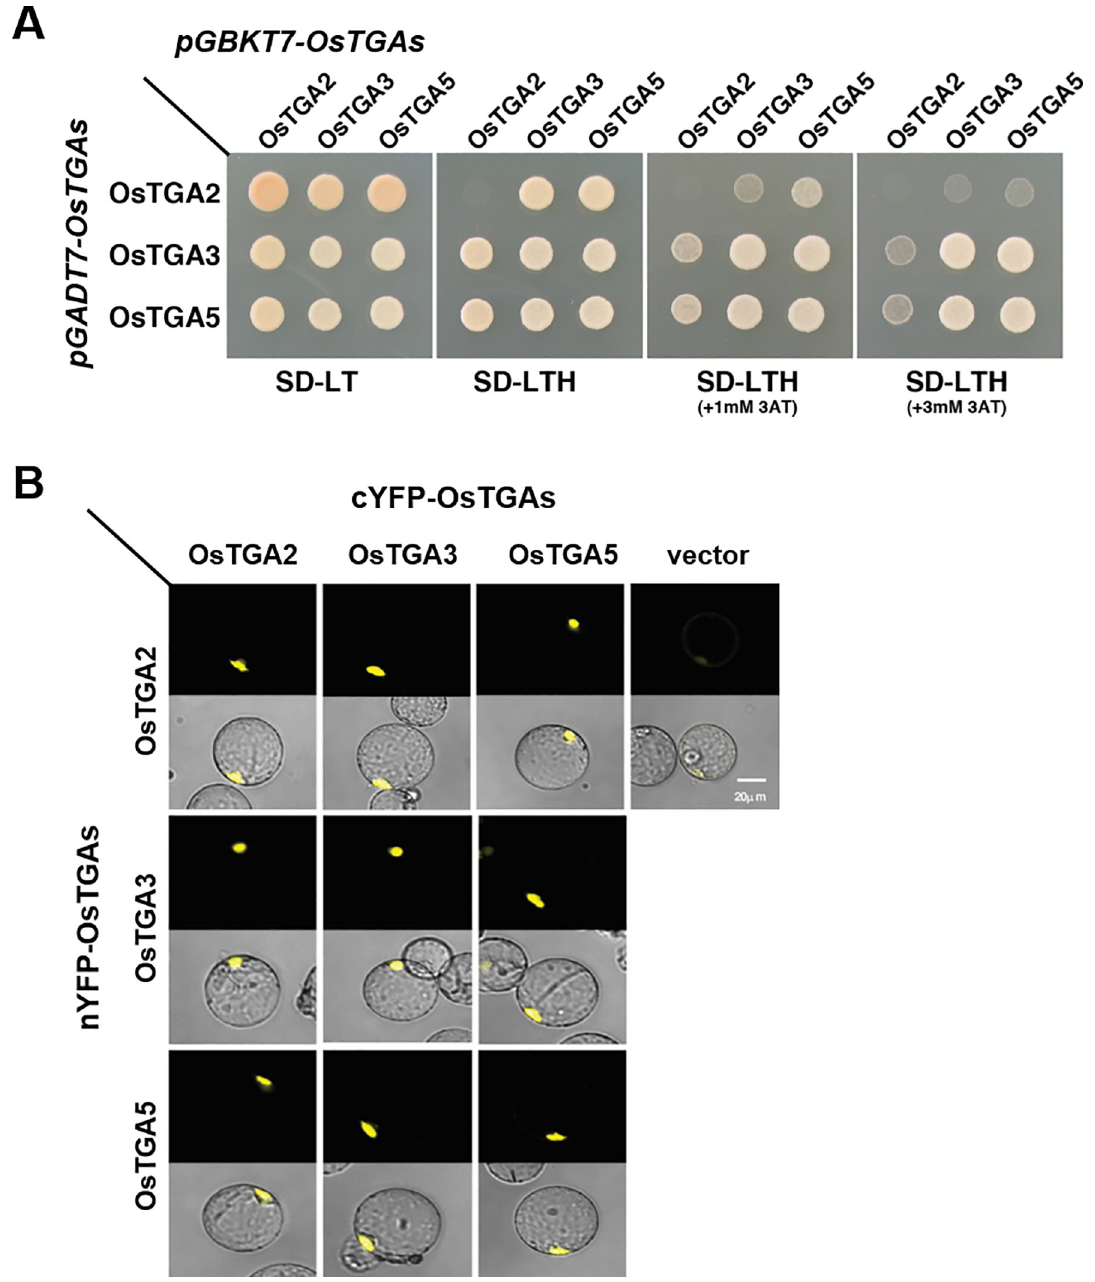
Fig 3. OsTGAs form dimers. (A)Yeast two-hybrid experiments demonstrate dimerization of OsTGAs. OsTGA2, OsTGA3, and OsTGA5 proteins fused to GAL4 DNA-binding domain (BD) and GAL4 activation domain (AD) expressed in yeast stain YH190. Cells were grown on selective media for 3 days at 30˚C before pictures were taken. (B) Visualization of protein-protein interactions in rice protoplast by BiFC